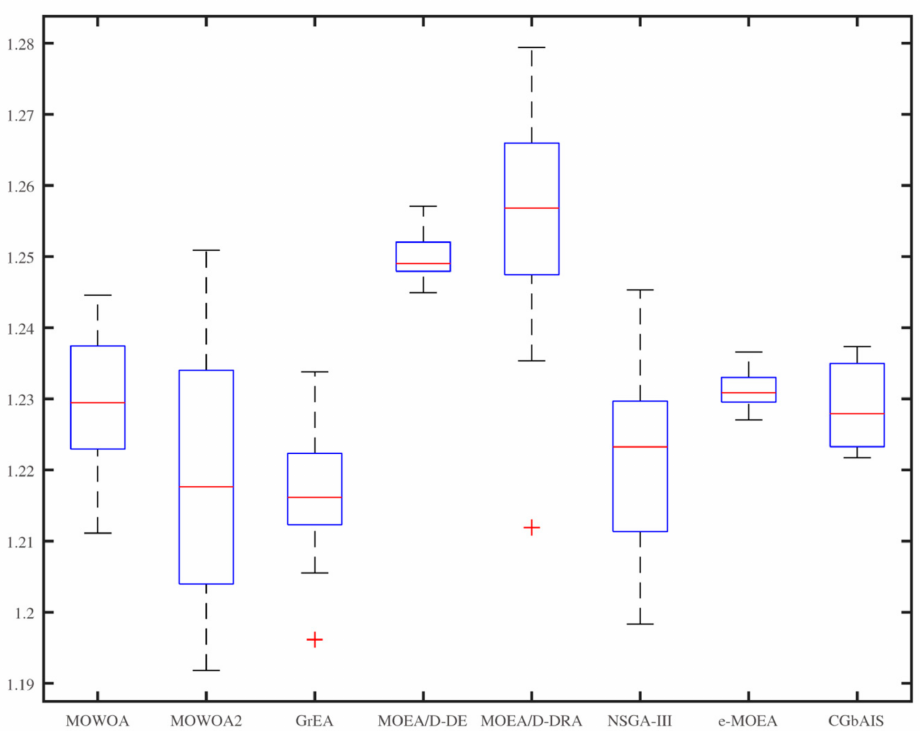
Figure 9. Time consumption of the different algorithms when the user number is 30.